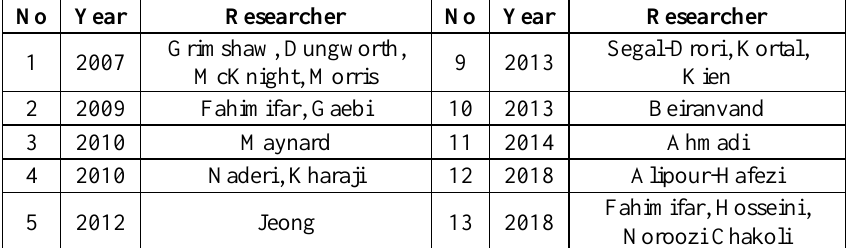
Table 2. Researches related to Comparison of printed and electronic books from the perspective of experts and